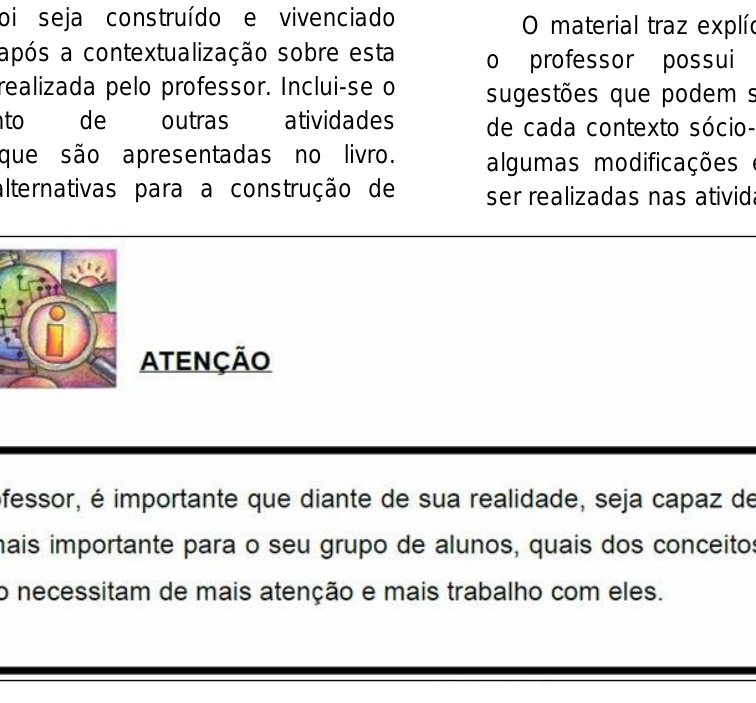
Figura 2- Recorte do livro em que se destaca a autonomia oferecida ao